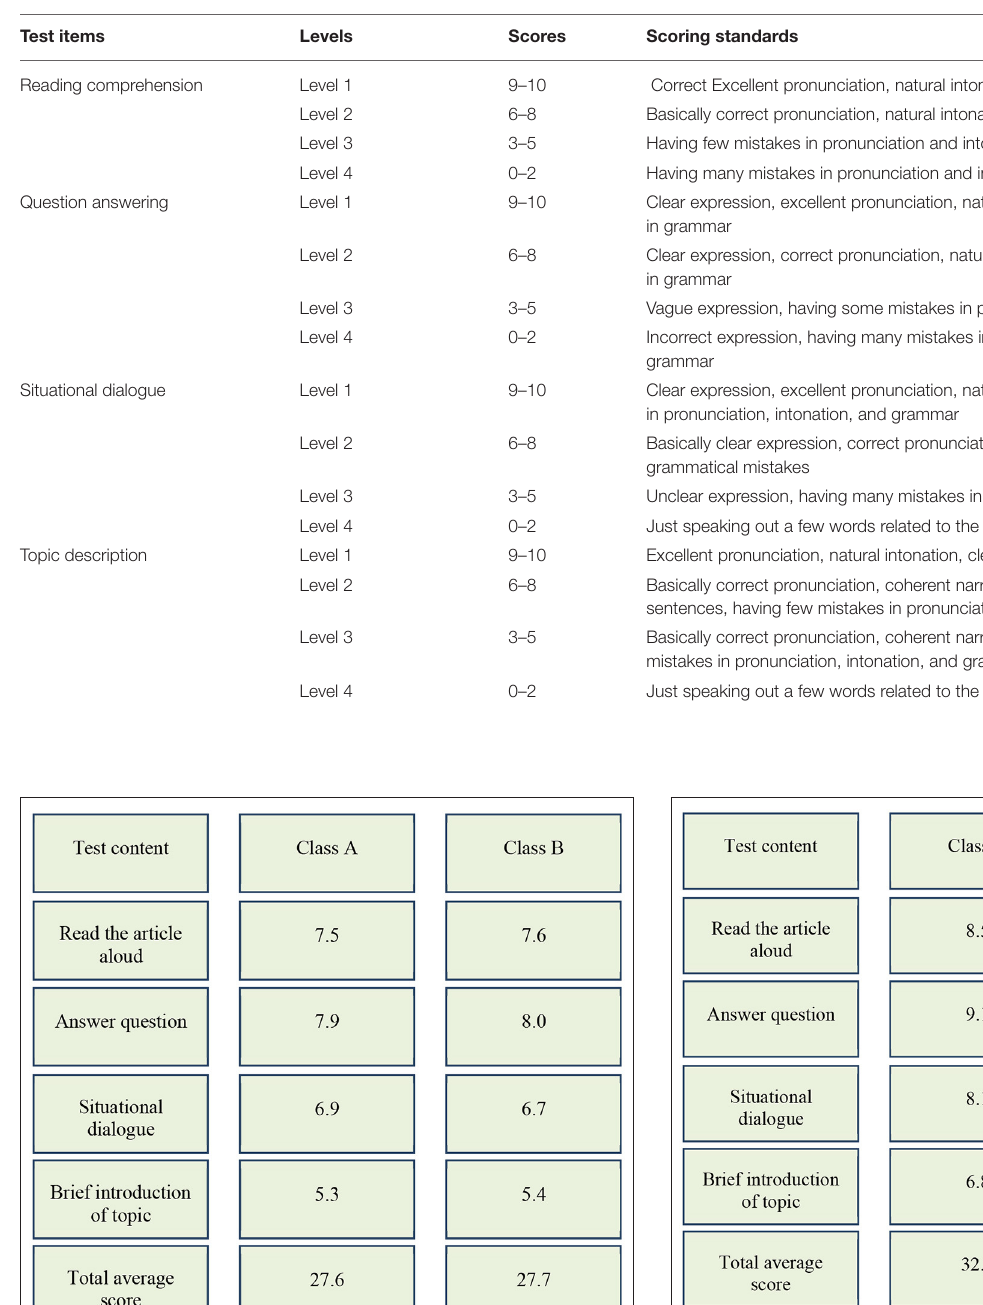
TABLE 1 | Scoring criteria for oral English test.